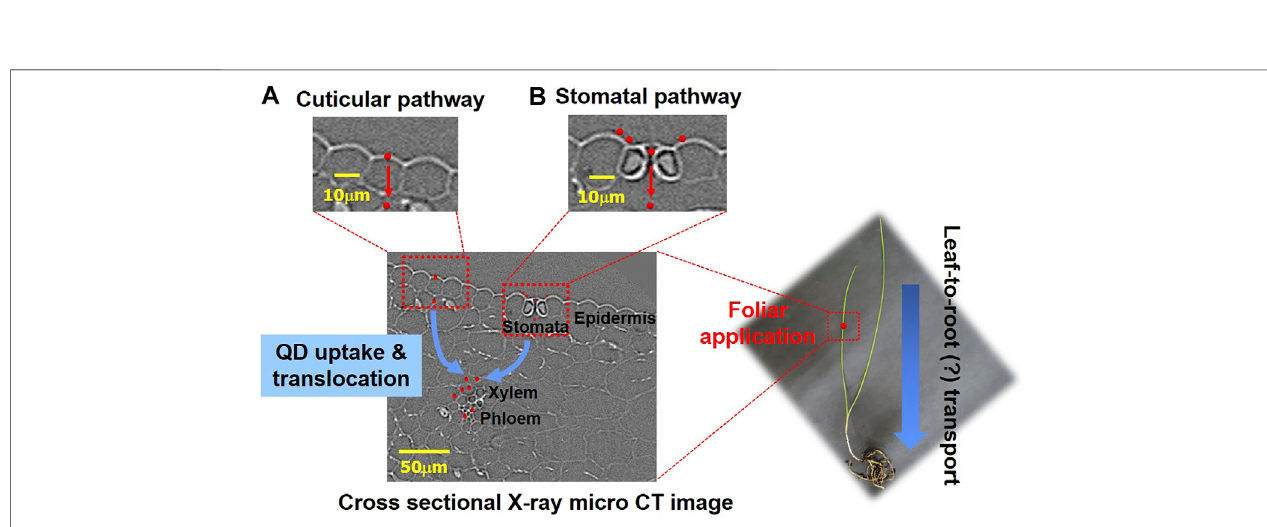
FIGURE7| Schematicoffoliaruptakeandtranslocation pathwaysofQDNPsinagarlicchiveplant. (A) PenetrationofQDNPsviacuticularcracks. (B) Penetration of QD NPs via stomata.